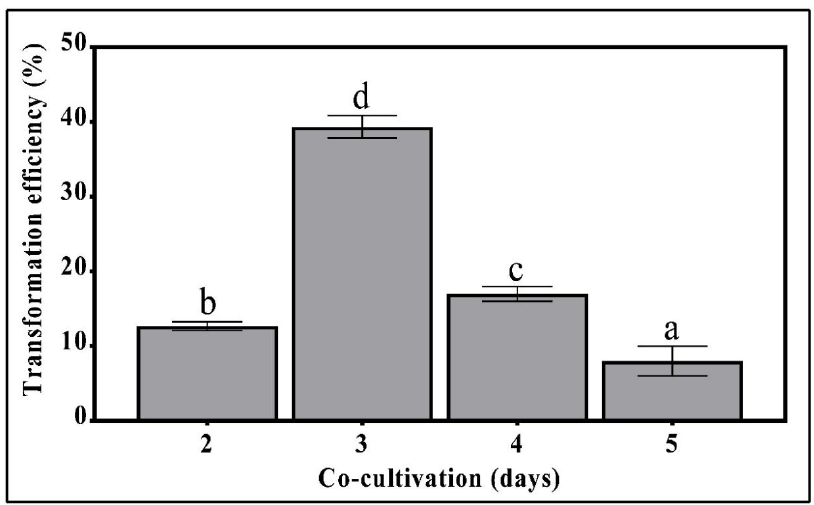
Figure 3. The effect of co-cultivation time prior to cefotaxime counter selection on the T. boudieri transformation efficiency. For each treatment, 100 mycelial cylinders were used. Values are mean ± SE ( n = 3), letters denote significant differences (p < 0.05).